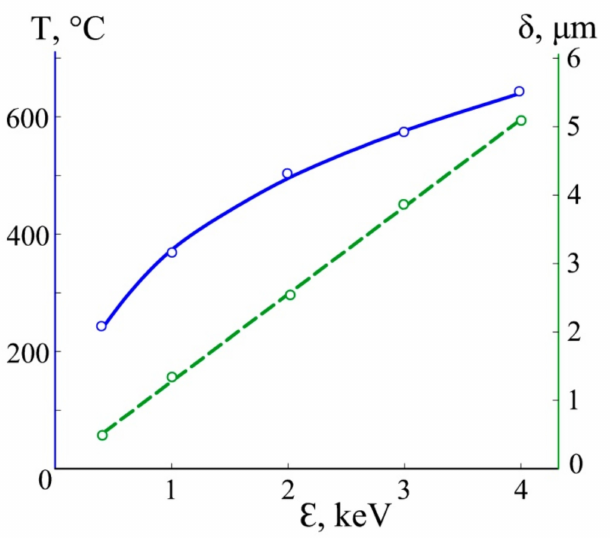
Figure 7. Dependence of the cutting plate temperature T (solid line) and thickness δ of the defective layer removed from its surface per one hour by the fast argon atoms (dashed line) on their energy ε .